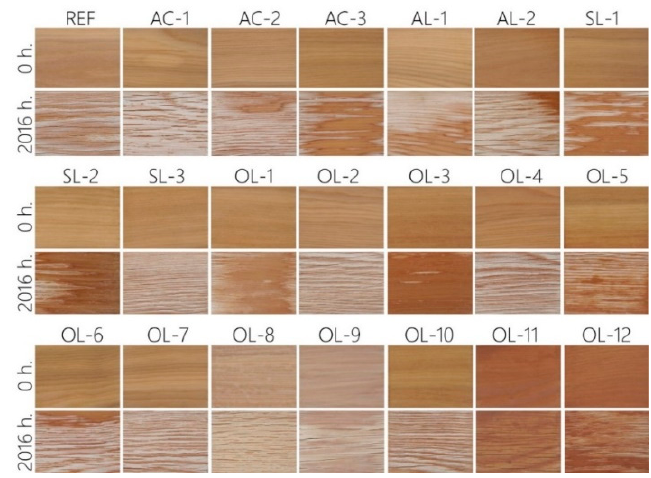
Figure 7. Visual evaluation of coating systems applied to Siberian larch before (0 h) and after (2016 h)